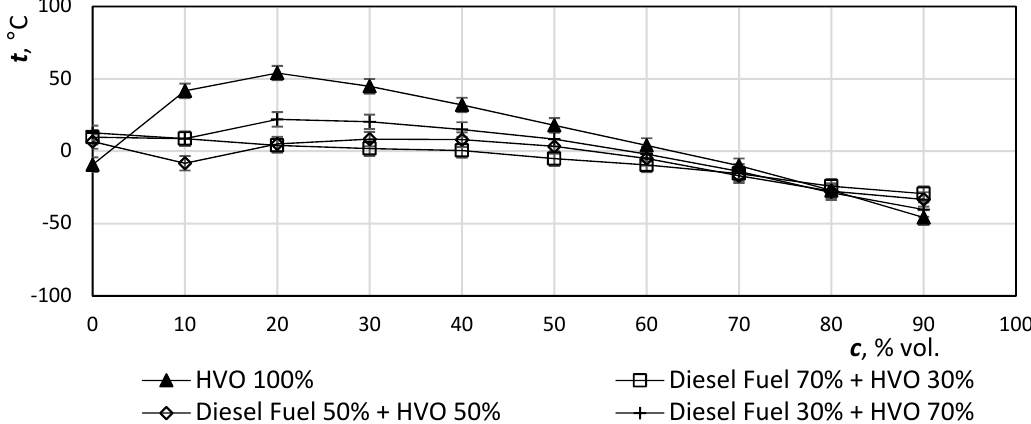
Figure 8. Changes in the mixed fuel distillation curve as compared to pure mineral diesel on the x -axis.